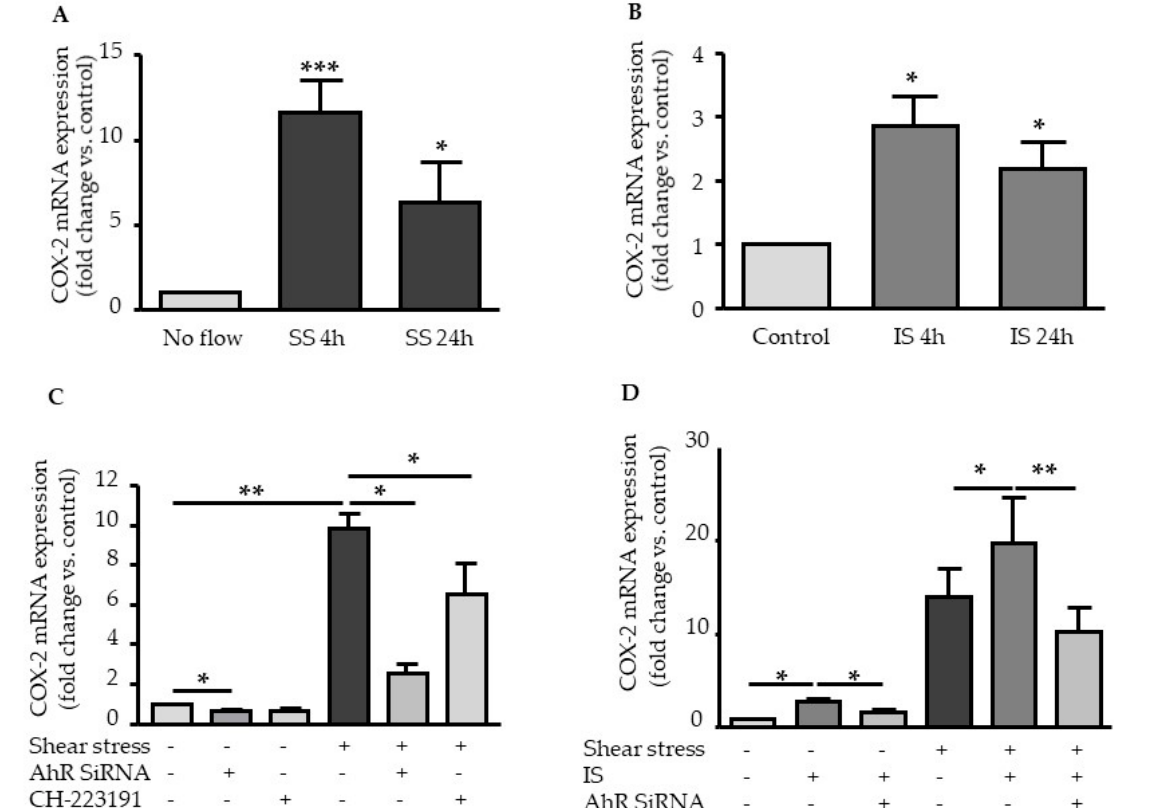
Figure 2. AHR-dependent additive effects of shear stress and IS on COX2 upregulation. Effect of shear stress 5 dynes/cm 2 ( A ) and IS 200 µM ( B ) on COX2 mRNA expression. Data, expressed as fold change vs. control, represent the mean ± SEM of n = 7 (A) and n = 4 (B) independent experiments. ( C ) Effect of the AHR inhibitor CH-223191 (10 µM) and of AHR siRNA on COX2 mRNA expression after 4 h of shear stress. Data represent the mean ± SEM of 4 independent experiments. ( D ) Effect of AHR siRNA on COX2 mRNA expression after a 4 h stimulation with IS 200µM. Data represent the mean ± SEM of 5 independent experiments. * p < 0.05, ** p < 0.01, *** p < 0.001.